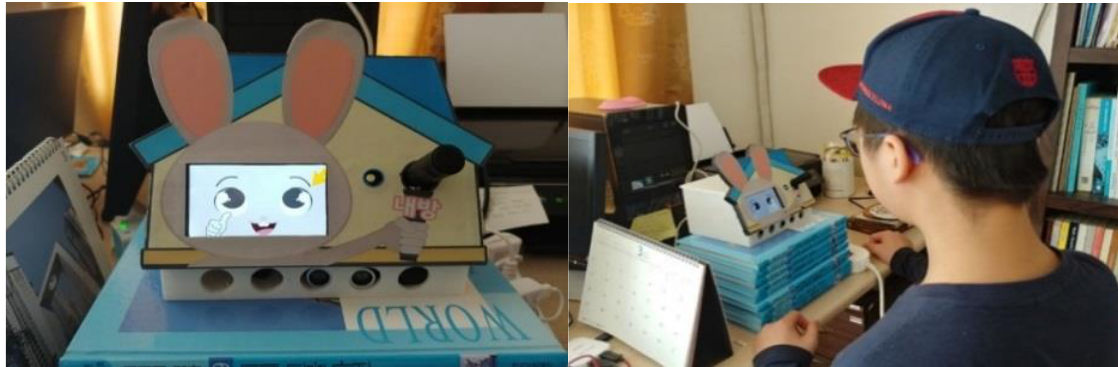
Figure 3. Participants and Home Companion-bot.